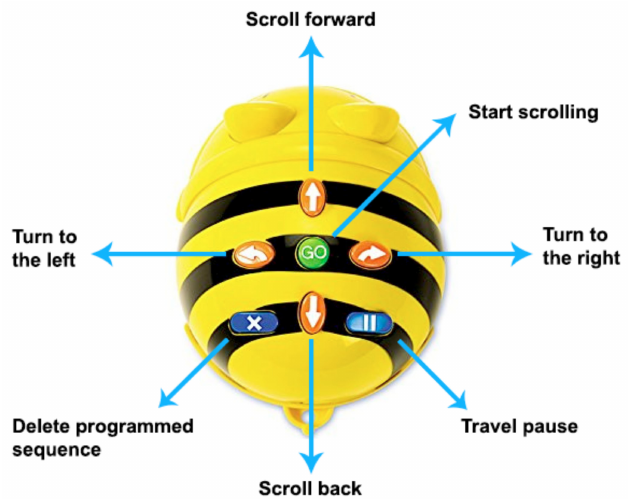
Figure 5. Bee-Bot ® Robot: description of buttons and their functions. Source: Own elaboration.